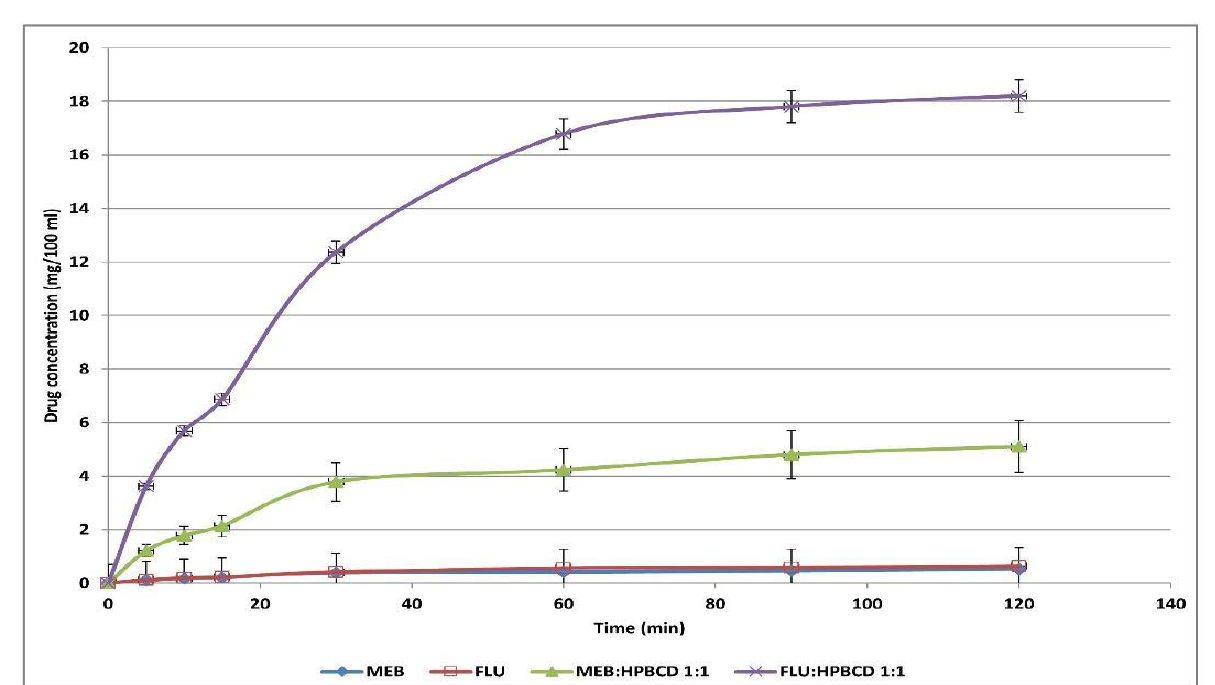
Figure 3. In vitro dissolution profiles of MEB, FLU, and their respective 1:1 mixtures with HPBCD.